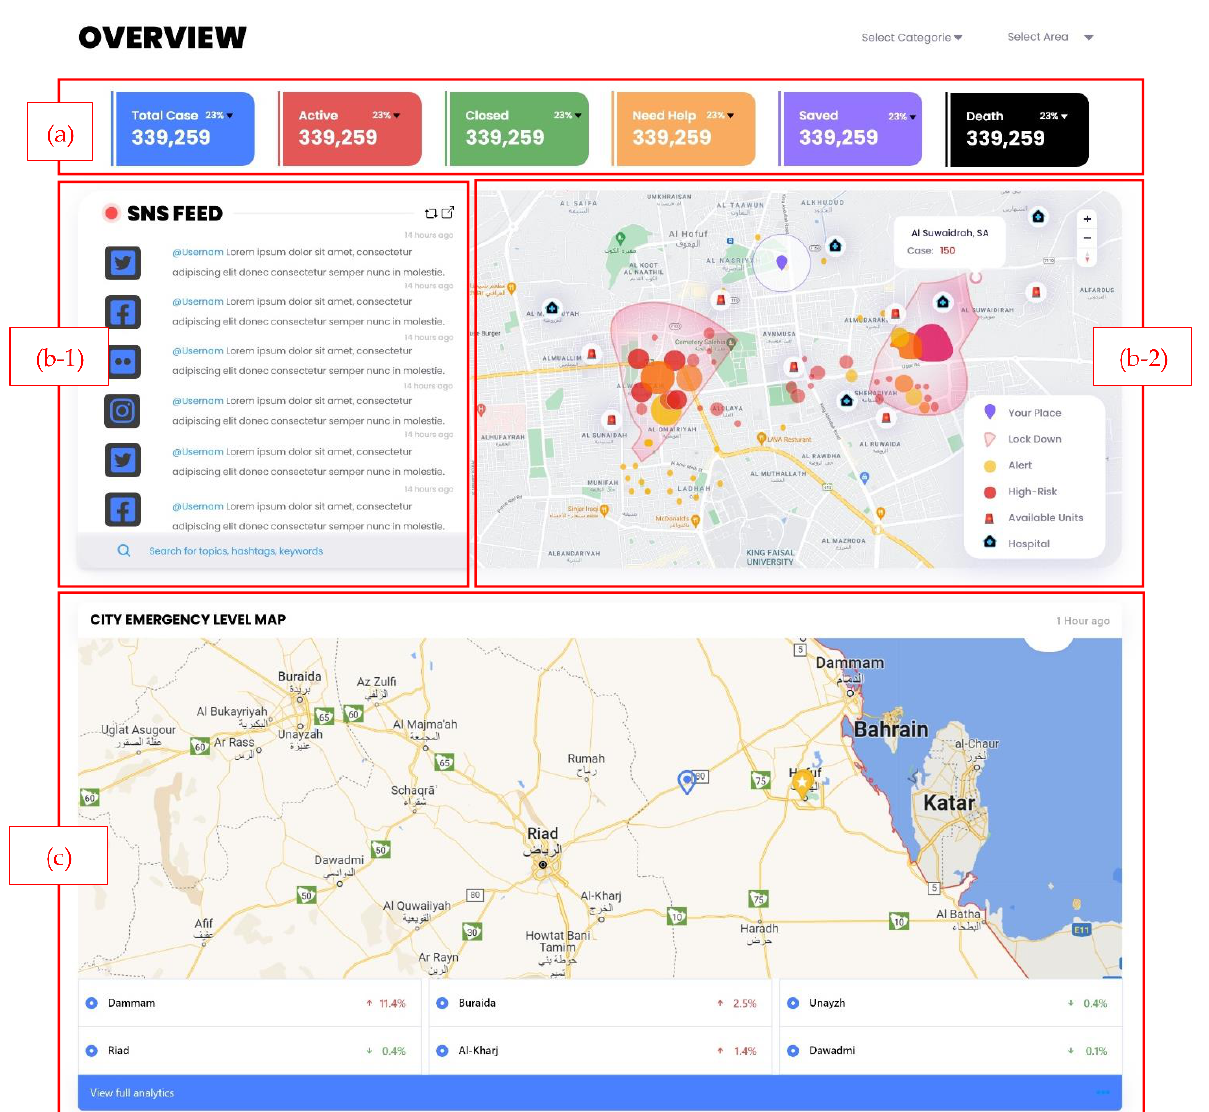
Figure 6. Multi-monitor visual analytics elements. ( a ) Total case statistics, ( b-1 ) live SNS feed, ( b-2 ) heatmap, and ( c ) city emergency level map.